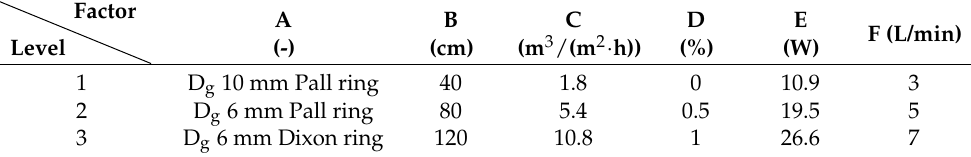
Table 4. The factors and levels involved in the denitration efficiency.